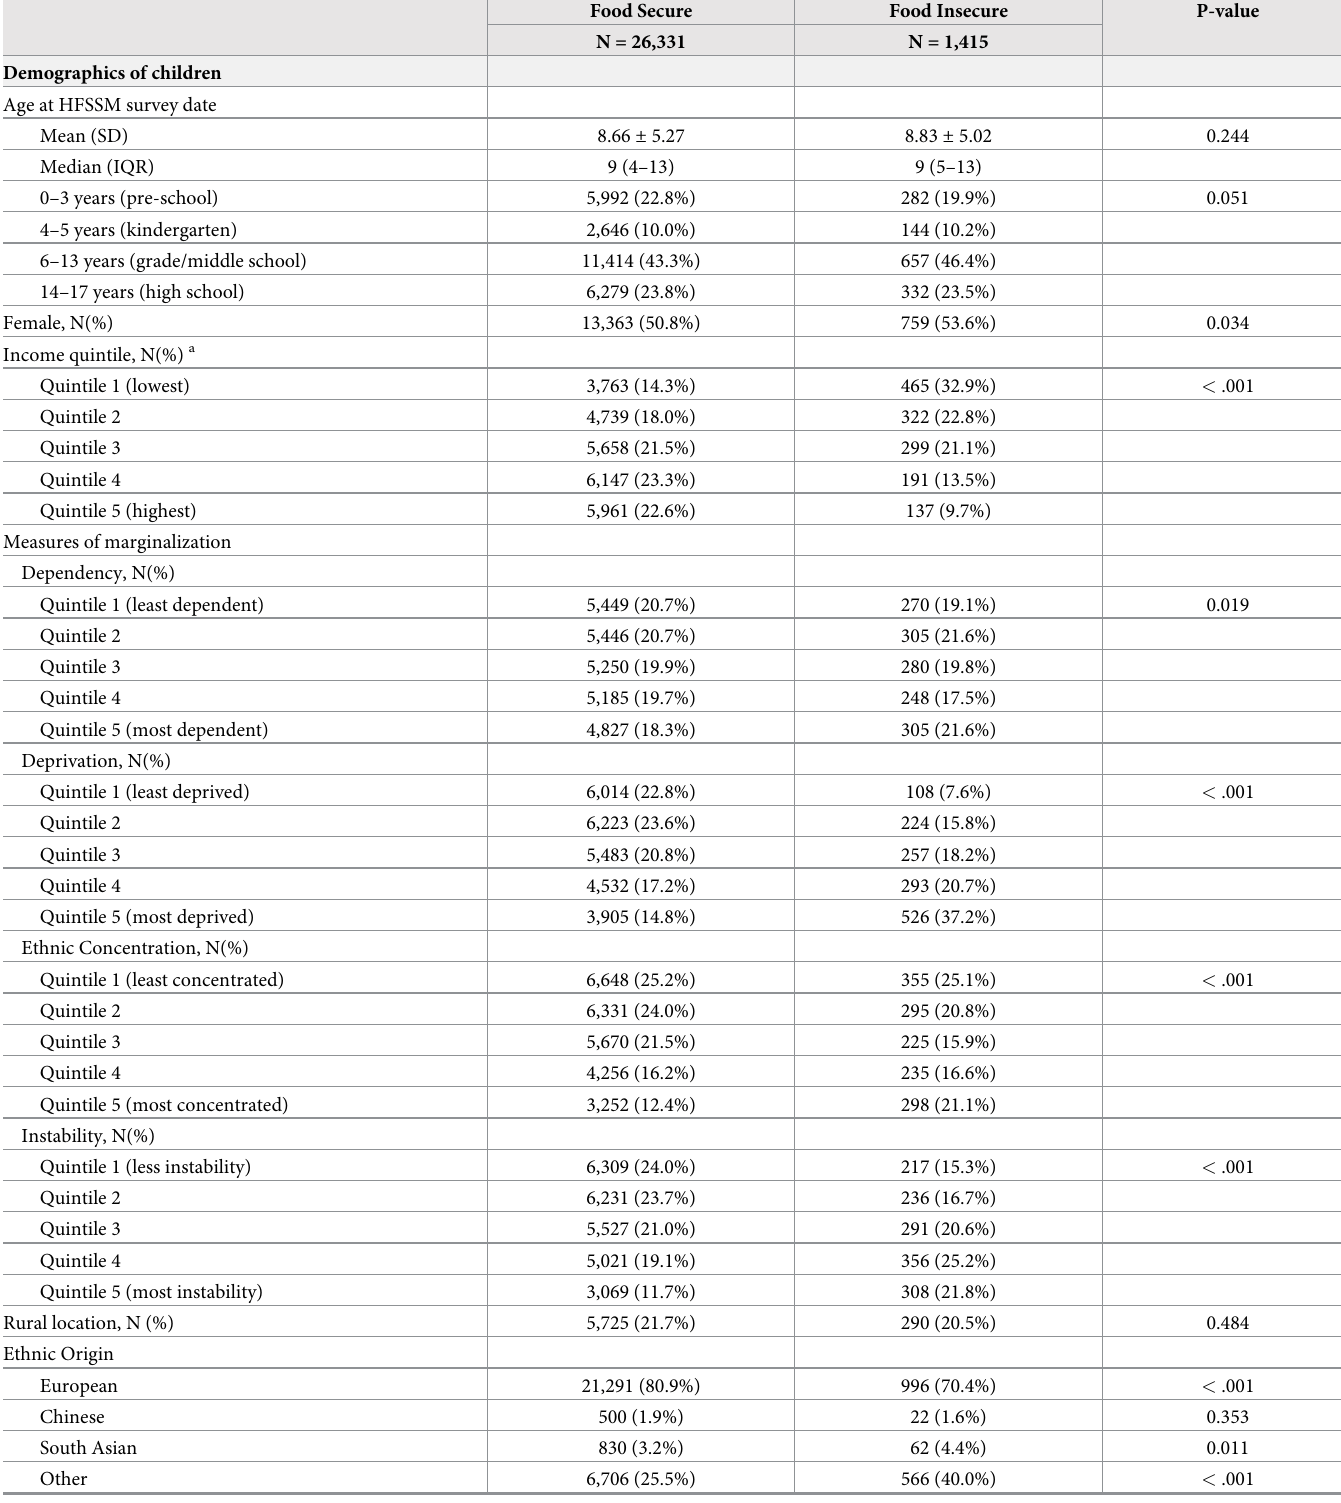
Table 1. Baseline characteristics of food insecure and secure children in Ontario,